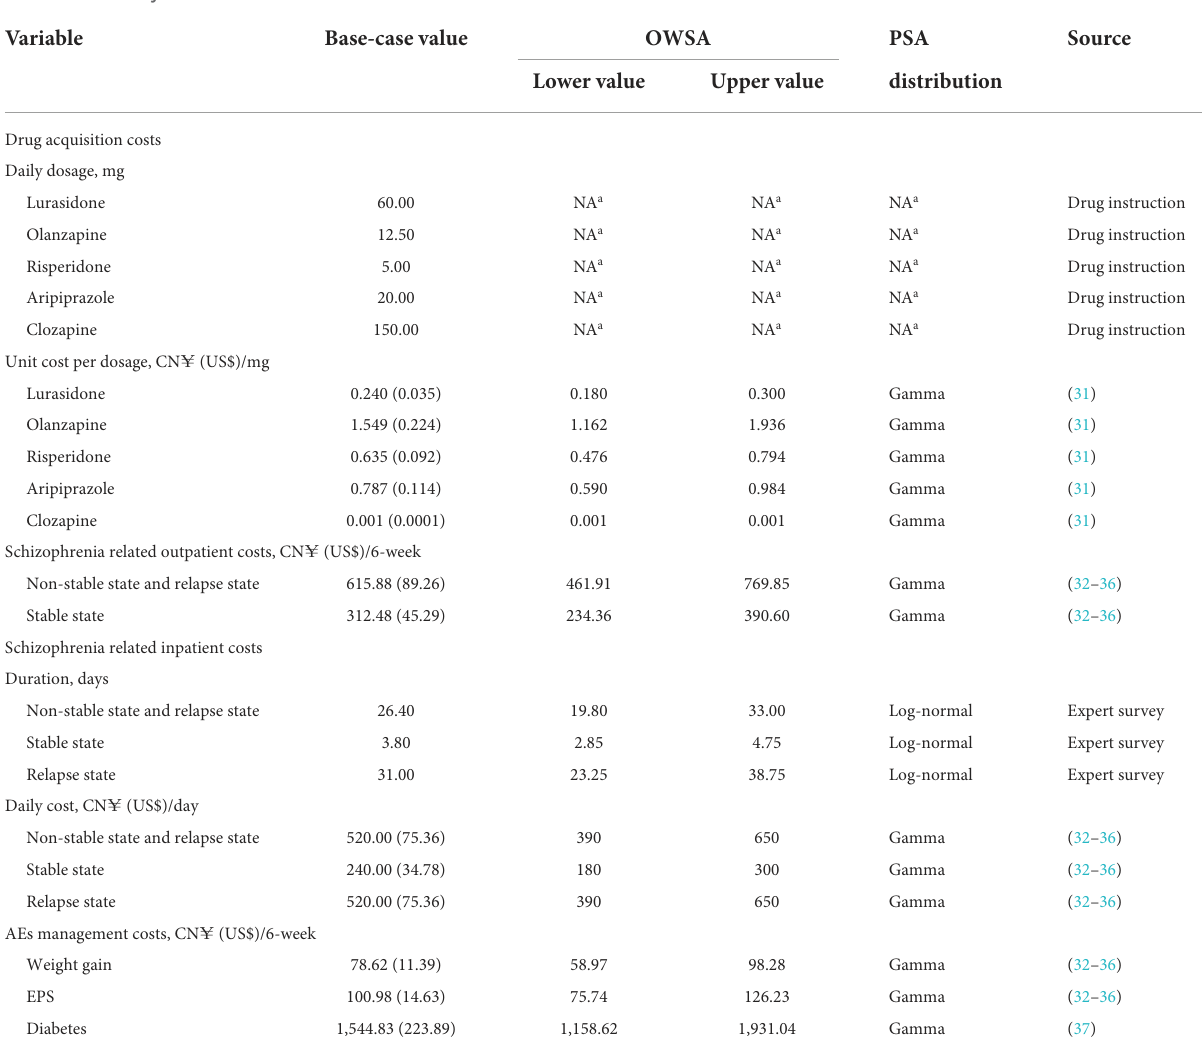
TABLE 2 Summary of cost data used in the